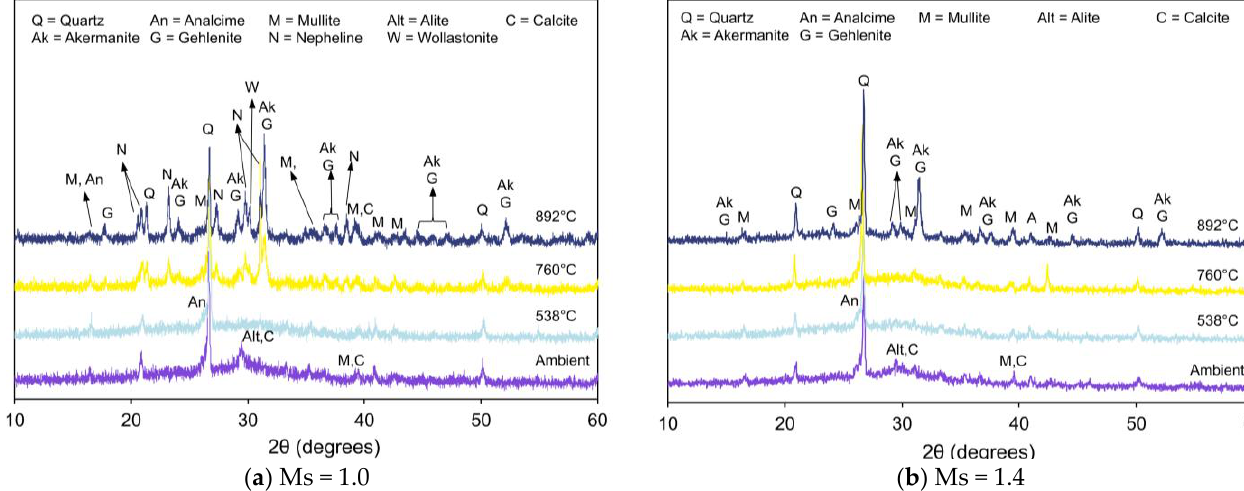
Figure 6. XRD pattern of FS 30P on exposure to elevated temperature.